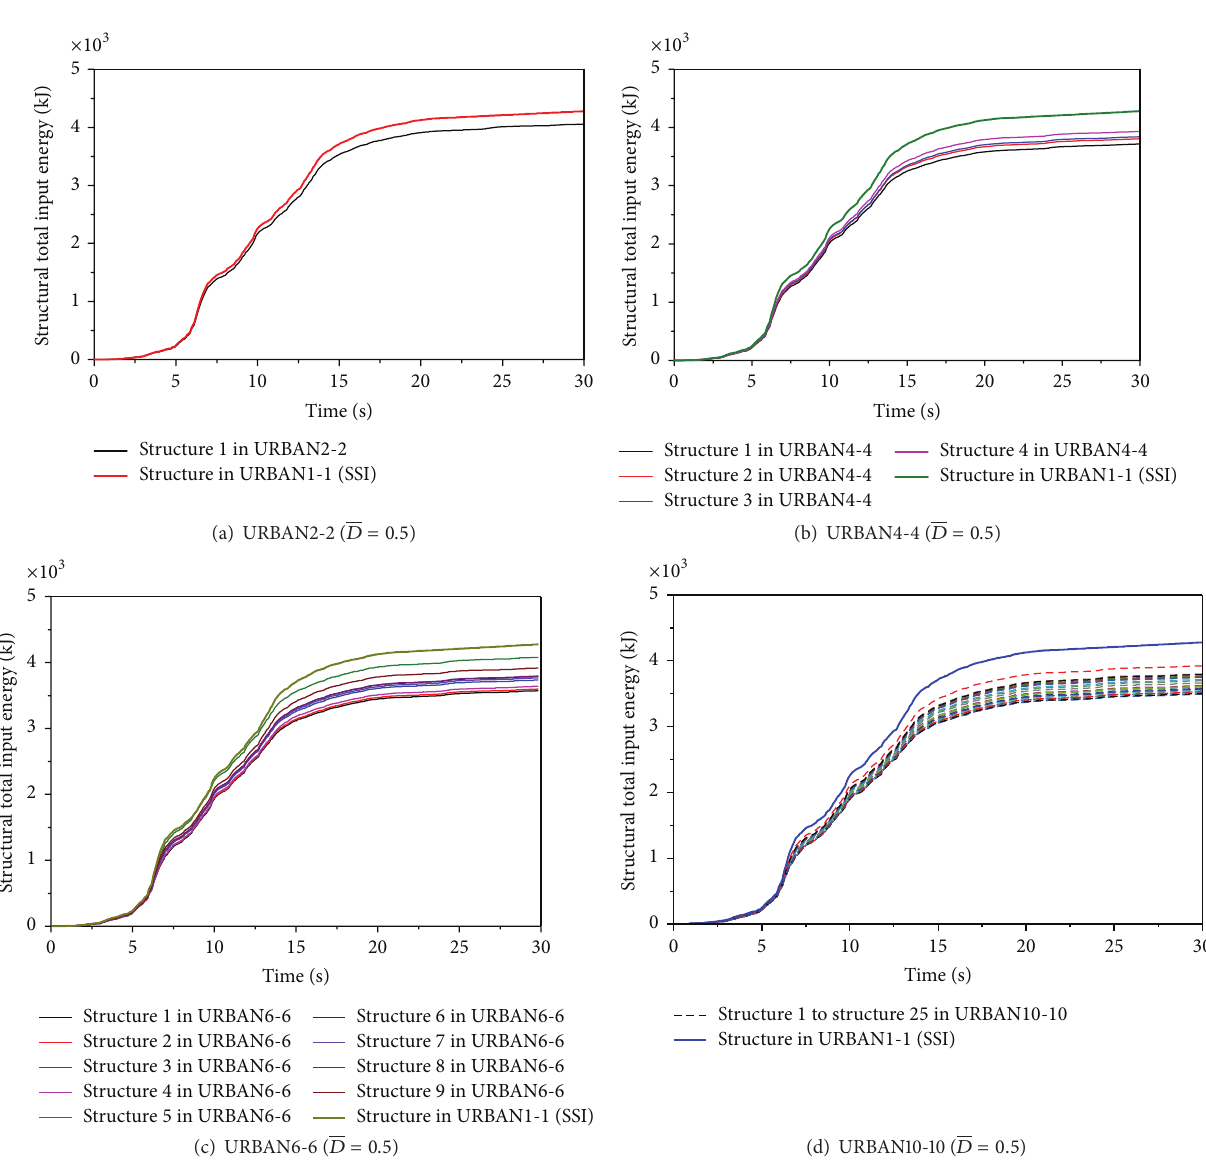
Figure 13: Structural total absorbed energy ( 𝐷 = 0.5 , MCH000, 𝑆𝑋